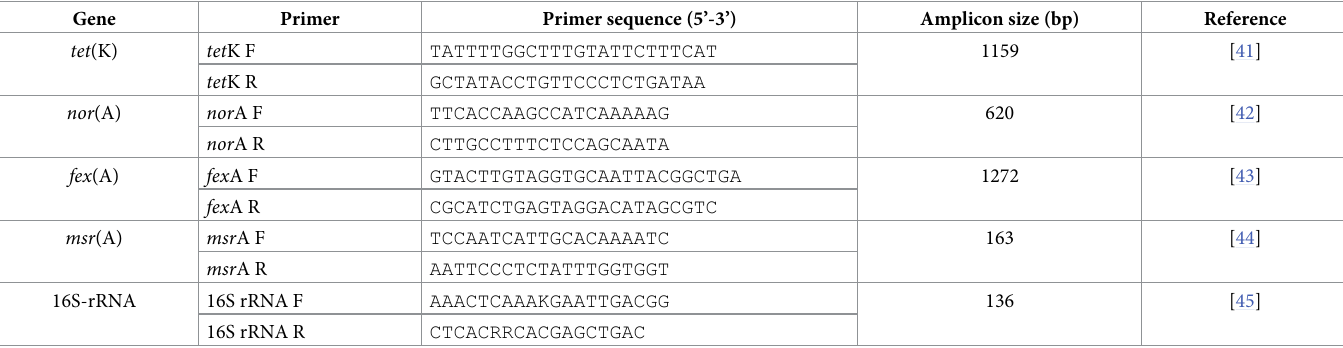
Table 1. Sequences of primers used in this study and amplicon